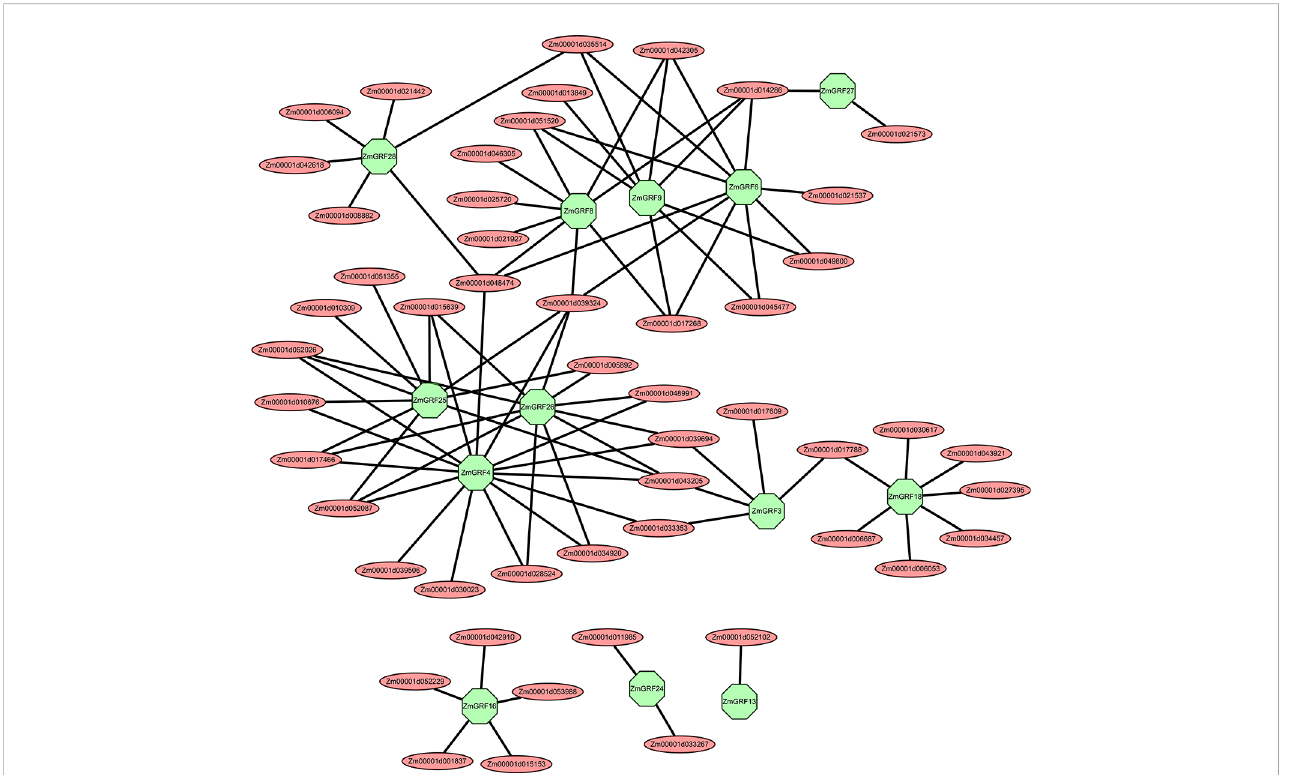
FIGURE 7 The transcriptional regulatory networks of 13 symbiosis-related maize 14-3-3s . These transcriptional regulatory networks were constructed by Cytoscape software. Red represents regulatory genes, and green represents symbiosis-related genes in the 14-3-3 gene